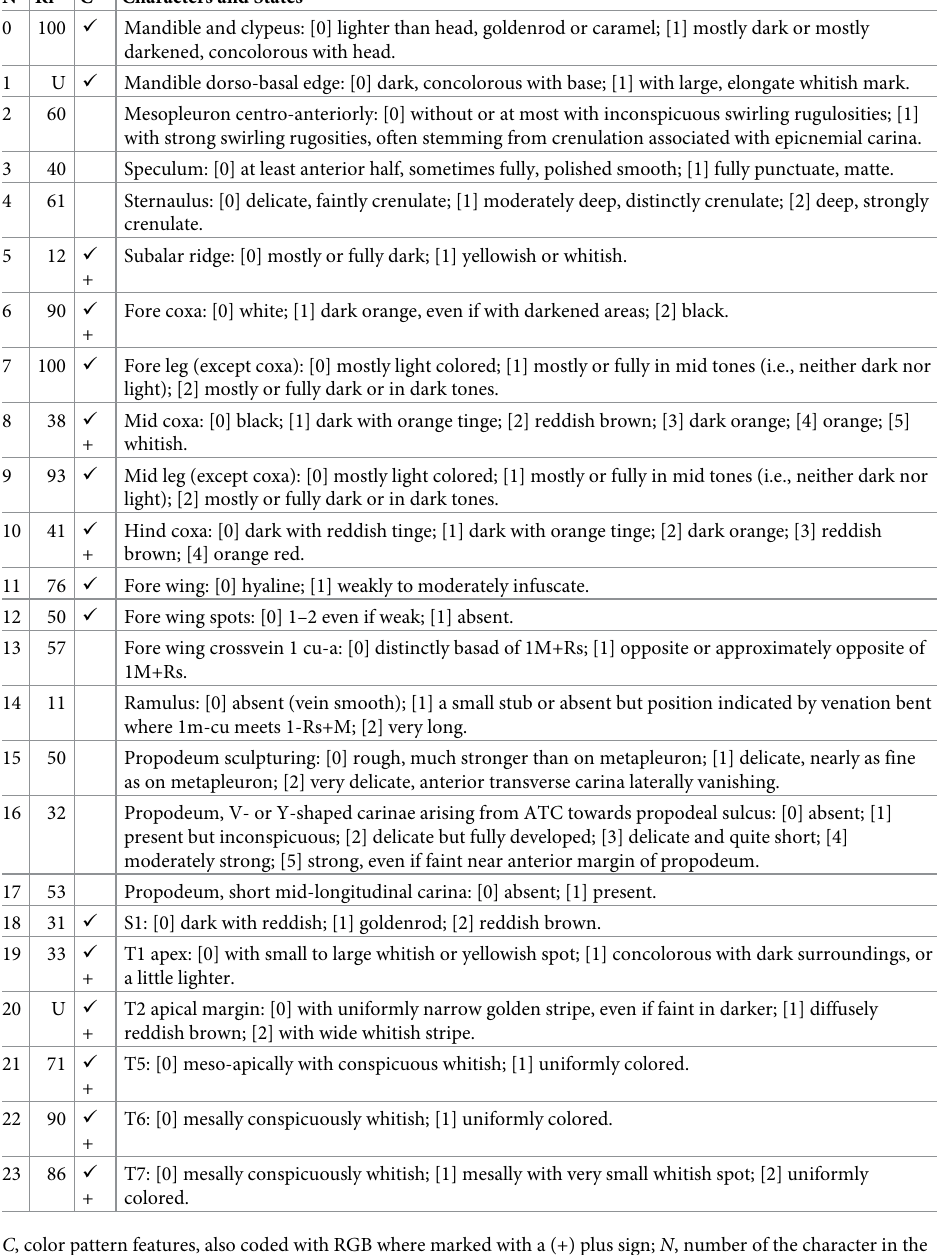
Table 1. Character coding used in the analyses of morphological variation. Coding reflects all relevant variation observed for females of Cryptoxenodon metamorphus sp. nov. N Ri C Characters and States 0 100